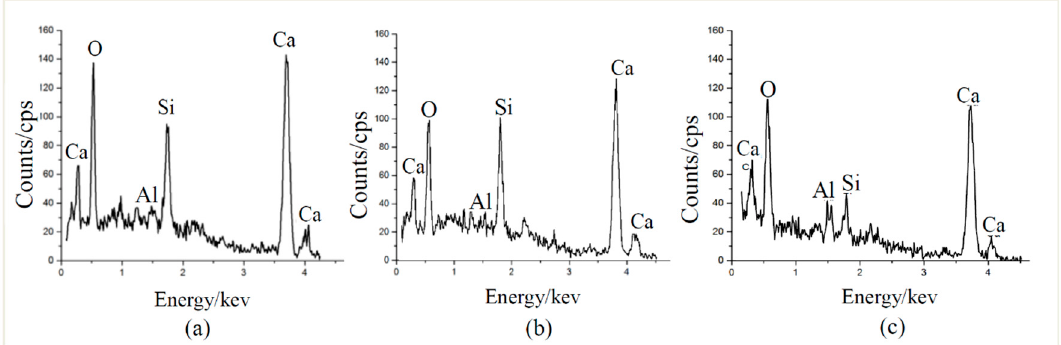
Figure 6. EDX results of ( a ) basalt fiber-mortar interface, ( b ) PVA fiber-mortar interface, and ( c ) glass fiber-mortar interface.